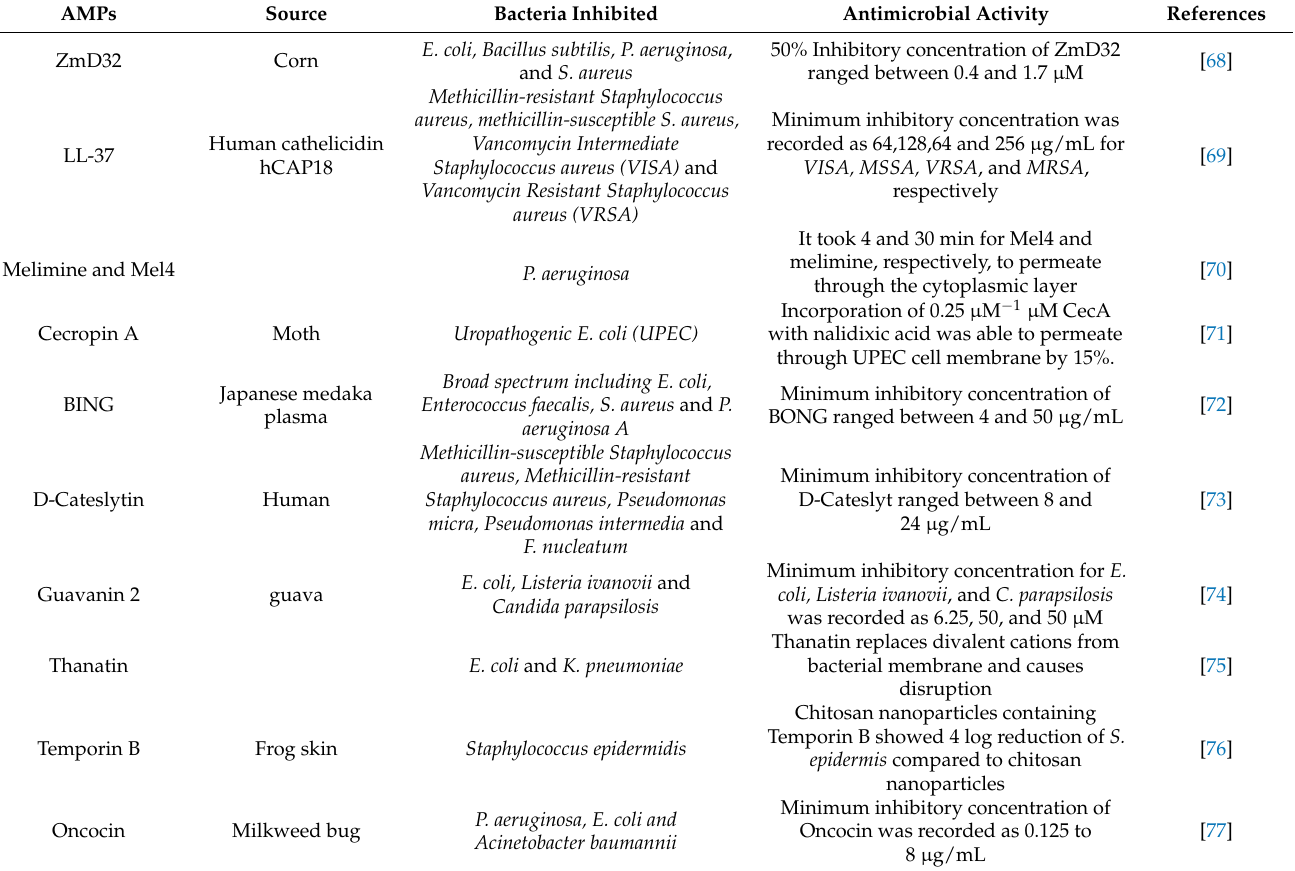
Table 2. List of some of the AMPs with putative antibacterial activity.